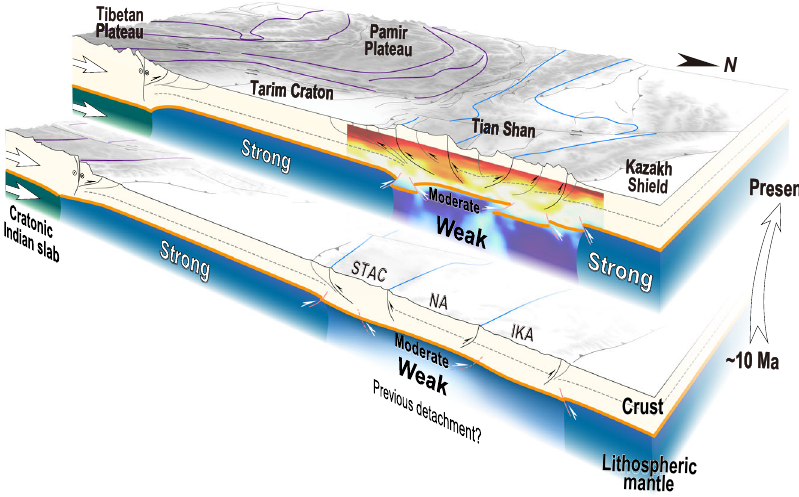
Fig. 3 Evolutionary pro fi les illustrating the rejuvenation of the Tianshan Orogen since ~10 Ma. An earlier detachment of the lithospheric root led to a weaker lithosphere in the Tianshan than in the surroundings. When the cratonic Indian slab directly impinged on the Tarim Craton, the contractional stress from the India-Asia convergence was effectively delivered to the Tianshan. Consequently, the lithosphere of the Tianshan underwent intense deformation, which was accommodated by inherited, structurally controlled brittle deformation in the shallow crust and by plastic deformation close to the Moho. IKA Issyk Kul Arc, NA Naryn Arc, STAC South Tianshan Accretionary discarded the following traces: (1) with unrealistic amplitudes (out of 0 ~ 1) at zero time; (2) whose products of convolution with the vertical component have a poor fi t with the radial component (<80% recovery of the observed radial seismogram); (3) that were signi fi cantly different from the corresponding bin-averaged RF (cross-correlation coef fi cient <0.5). After the quality control process, a reliable, successive RF dataset was established (Supplementary Fig. 1a – c). We applied the harmonic analysis method 60 to extract the azimuthally independent RFs with minimal potential in fl uences of tilting interface and azimuthal anisotropy (Supplementary Fig. 1d – h). The piercing points of the Ps phases at a depth of 60 km sample a circular area with a diameter of 0.5° centered on each station (Fig. 1b), similar to the horizontal grid scale of the Rayleigh wave dispersion (DPs) (0.5°× 0.5° grids) used in this study 61 . However, the harmonic analysis method may be less effective when the azimuthal coverage of RFs is poor, due to the limits of the distribution of events and data quality. To minimize the bias in estimating the average RF for stations with uneven azimuthal coverage, we calculated bin-averaged RFs within a bin of 30° back-azimuth, and then stacked them to estimate the average RFs and corresponding uncertainties. Subsequently, the average RFs were used in the joint inversion with the DPs. Supplementary Fig. 2b – d present the average RFs with Gaussian coef fi cients of 1.0, 2.0, and 3.5 for each station, and the Pms phases are traceable continuously along the cross-section.